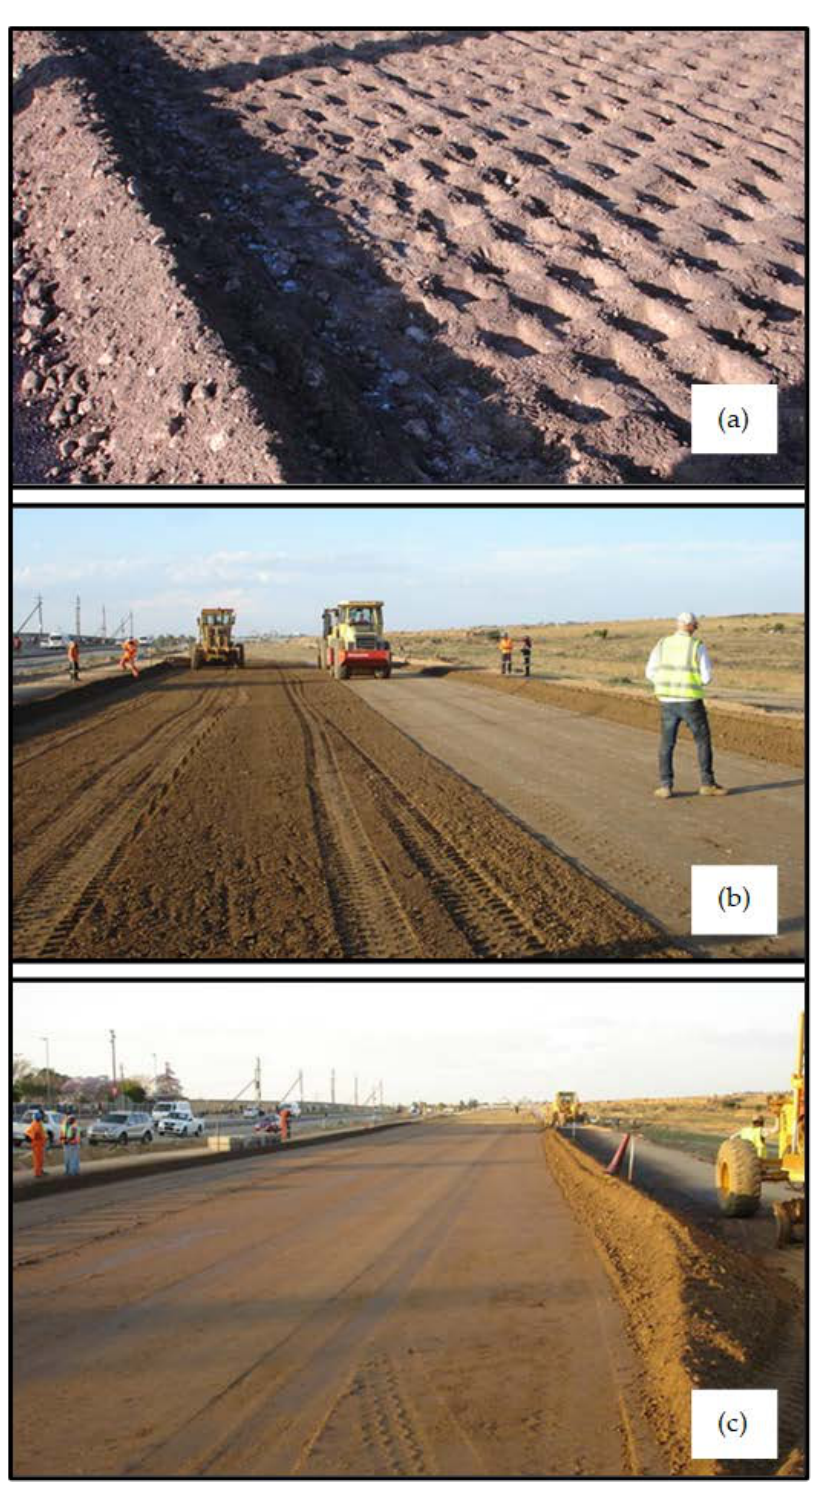
Figure 15. Compaction of the layer with the anionic NME mixed into the layer using conventional equipment; ( a ) using a sheep-feet roller; ( b ) followed by a vibratory steel-drum roller and a pneumatic roller to create a smooth surfacing; and ( c ) a small percentage of the NME mix is retained in the tanker as an enrichment of the top of the layer before final compaction (note that, similar to normal emulsion stabilisation, clean water should not be sprayed onto the layer).